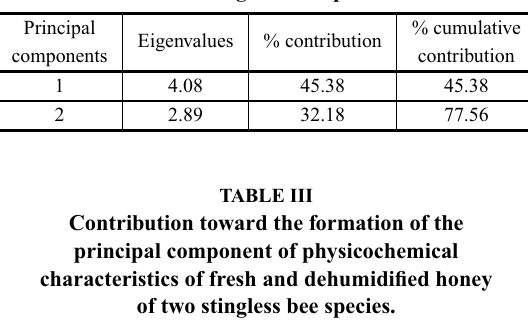
Variance estimates (eigenvalues), contribution percentage, and cumulative contribution (%), obtained by Principal Components Analysis, considering physicochemical characteristics of fresh and dehumidified honey